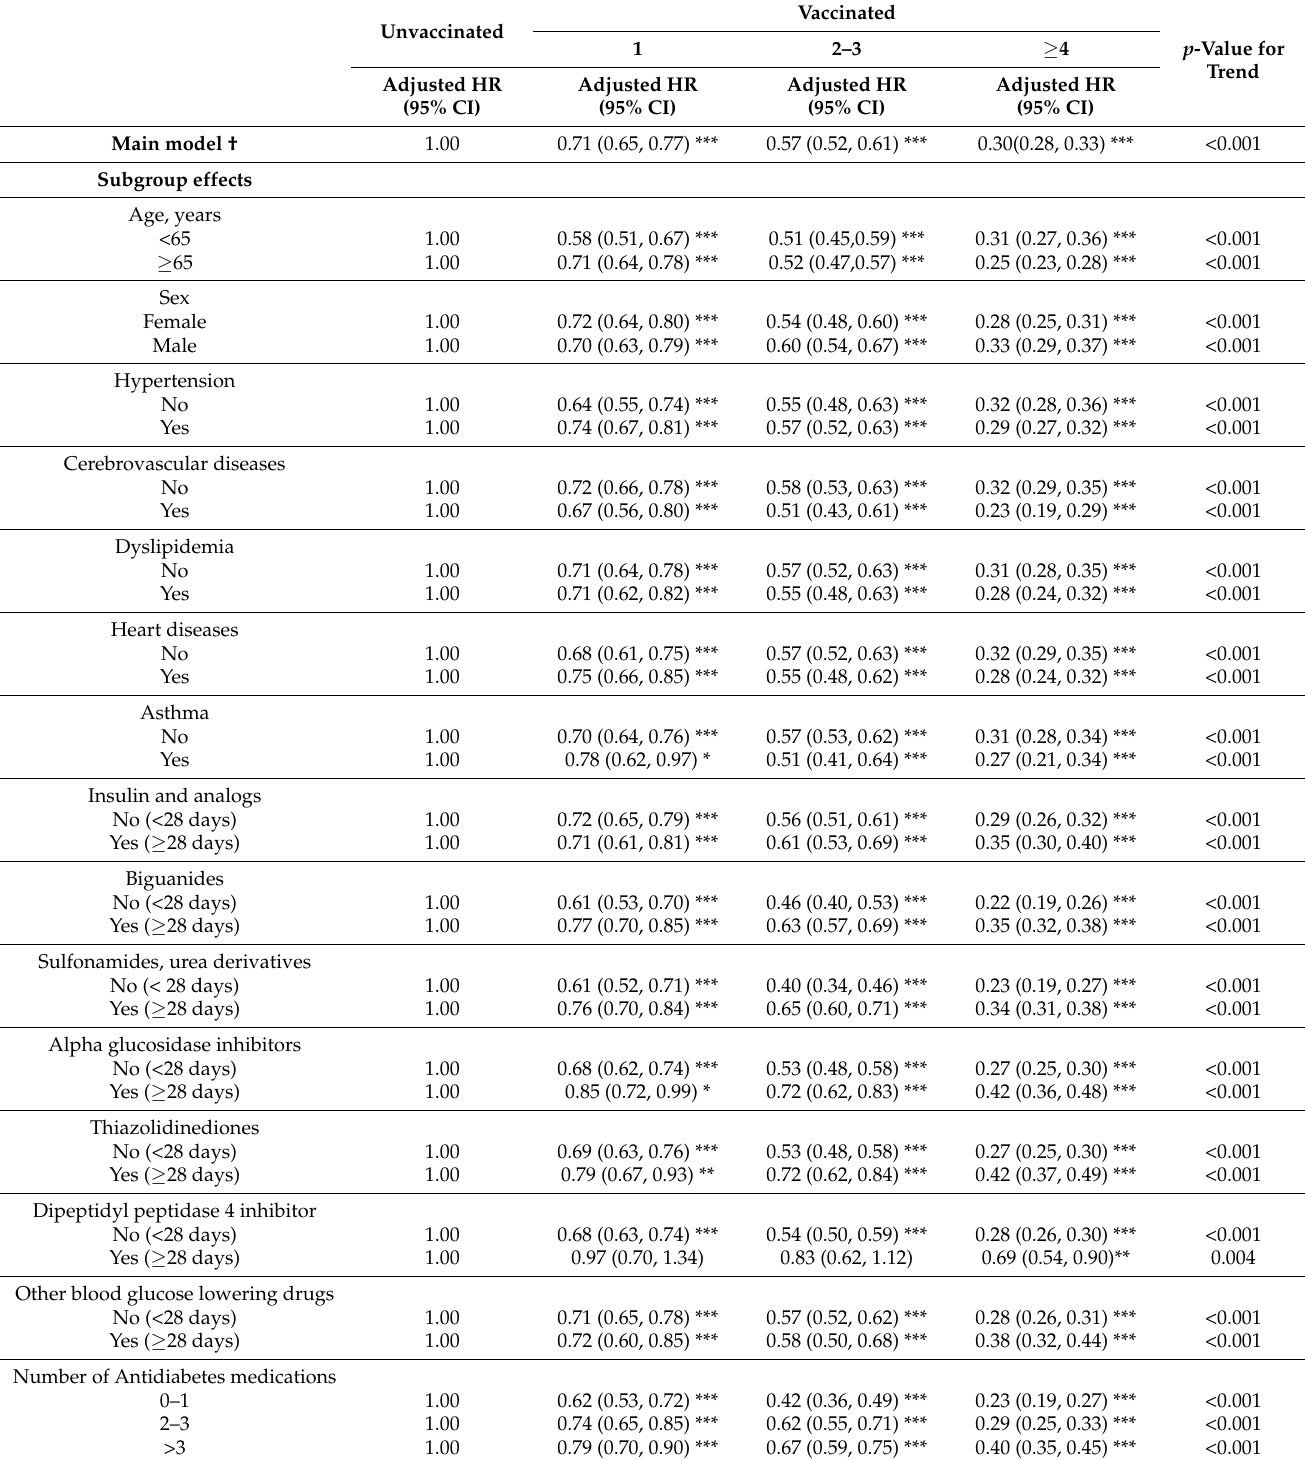
Table 4. Sensitivity Analysis of the Adjusted HRs for Vaccination in the Risk Reduction of CKD in All